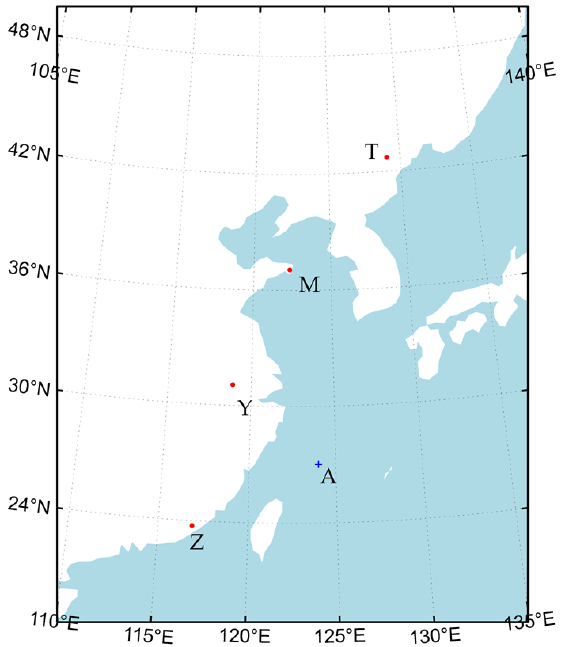
Figure 8. Stations location distribution.